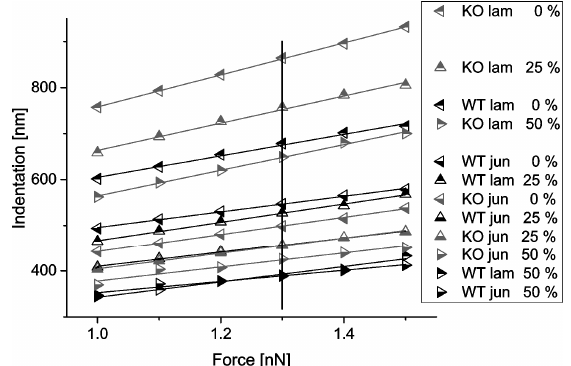
Figure 6. Average indentation depths as function of force for keratin WT and knockout (KO) cells at three different strains. Each symbol represents an average of 14 independent measurements. Scatter similar to Figure 7a,b; not indicated here for the sake of clarity. Slopes were fitted at F 0 = 1.25 nN of each data set. Vertical bar at 1.3 nN indicates data shown below in Figure 7a,b.